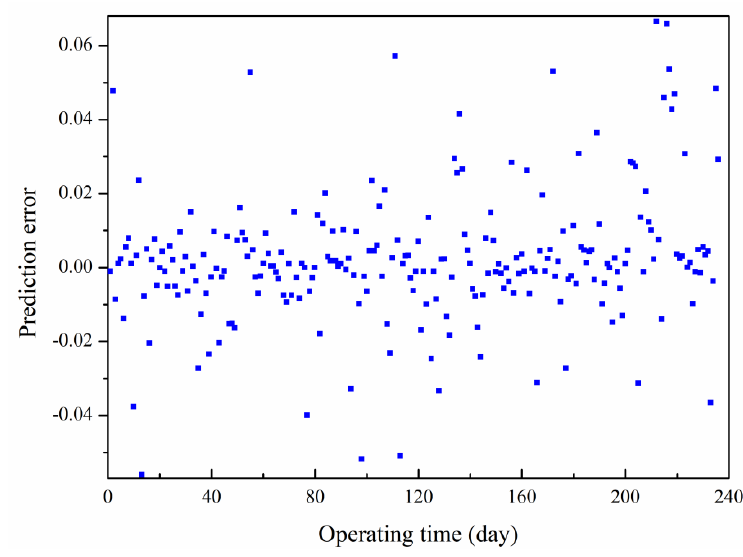
Figure 7. Prediction error of the SVM method.